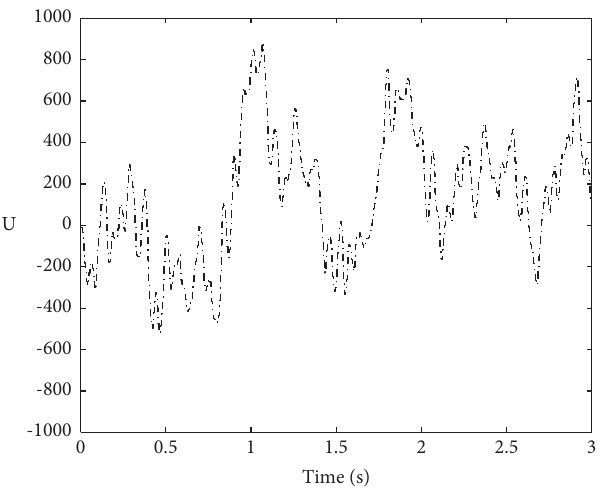
Figure 11: Output force of the controller. Table 3: Simulation suspension optimization results. RMS (suspension